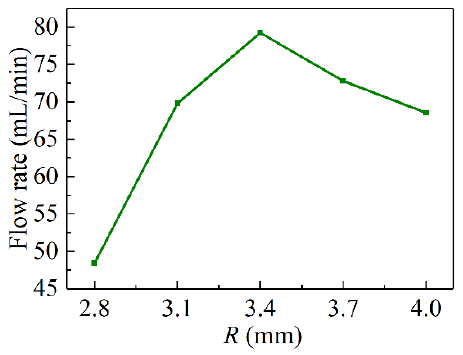
Figure 13. Corresponding maximum flow under different R.